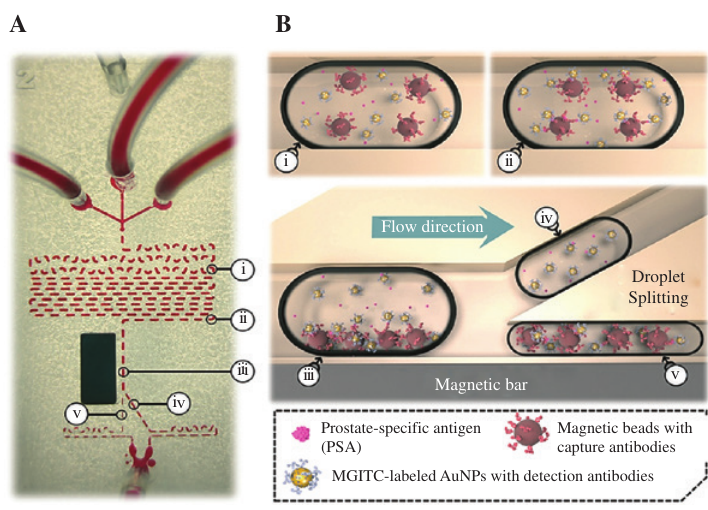
Figure 8: (A) Optical image of the entire microdroplet channel filled with red ink. (B) Sequential droplet splitting mechanism for the wash- free magnetic immunoassay of PSA cancer markers: (i) mixing of reagents, (ii) formation of immunocomplexes, (iii) isolation of magnetic immunocomplexes, (iv) supernatant including unbound SERS nanotags and (v) separated magnetic immunocomplexes. Reprinted with permission from [30] Copyright 2016 American Chemical